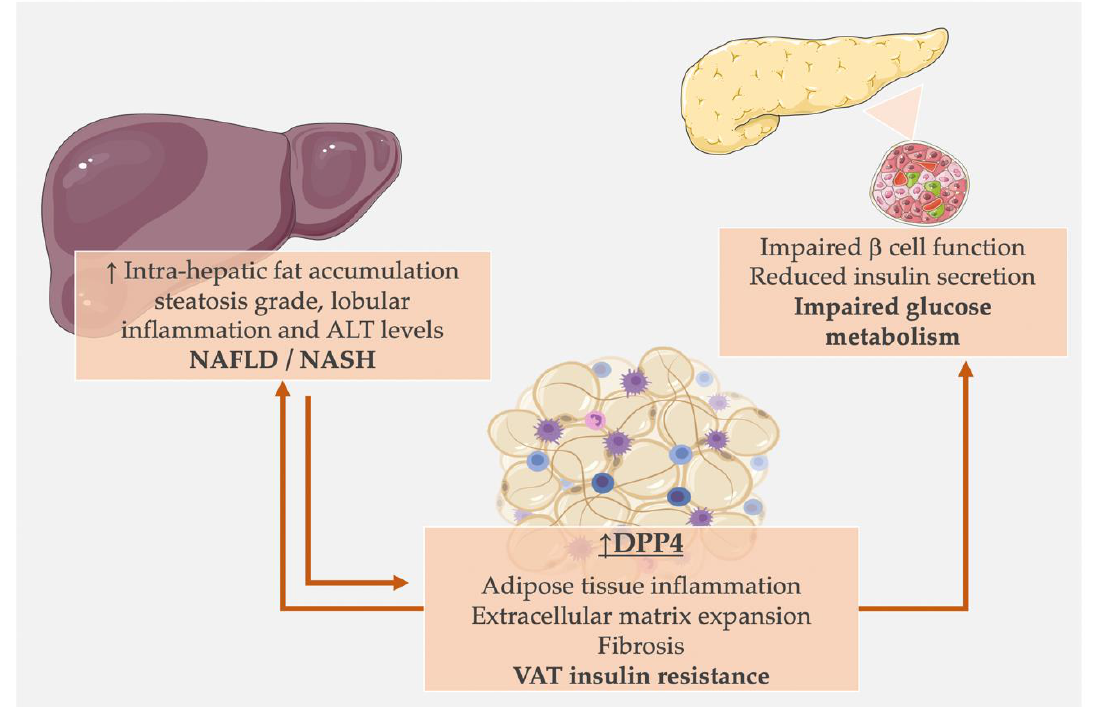
Figure 2. DPP4 in metabolic diseases: potential mechanisms linking high DPP4 to metabolic impairment. Arrows indicate the direction of the effects. Abbreviations: DPP4: dipeptidyl peptidase 4, ALT: alanine aminotransferase, NAFLD: nonalcoholic fatty liver disease, NASH: nonalcoholic steatohepatitis, VAT: visceral adipose tissue. See Sections 4 and 5 for detailed descriptions and references.